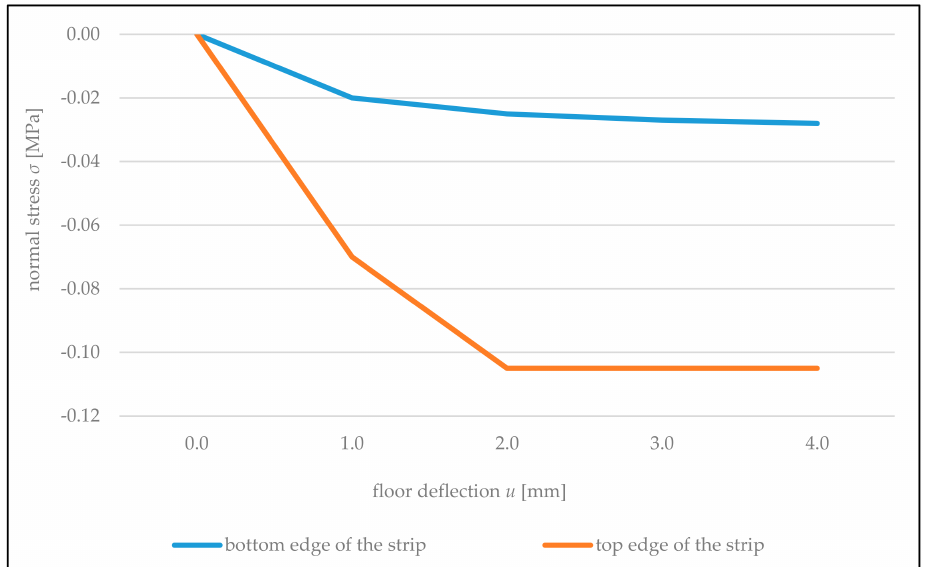
Figure 18. Graphs of changes in regular stresses on edges of the wall strip above the opening in the wall rigidly connected with cross walls, depending on the floor deflection u